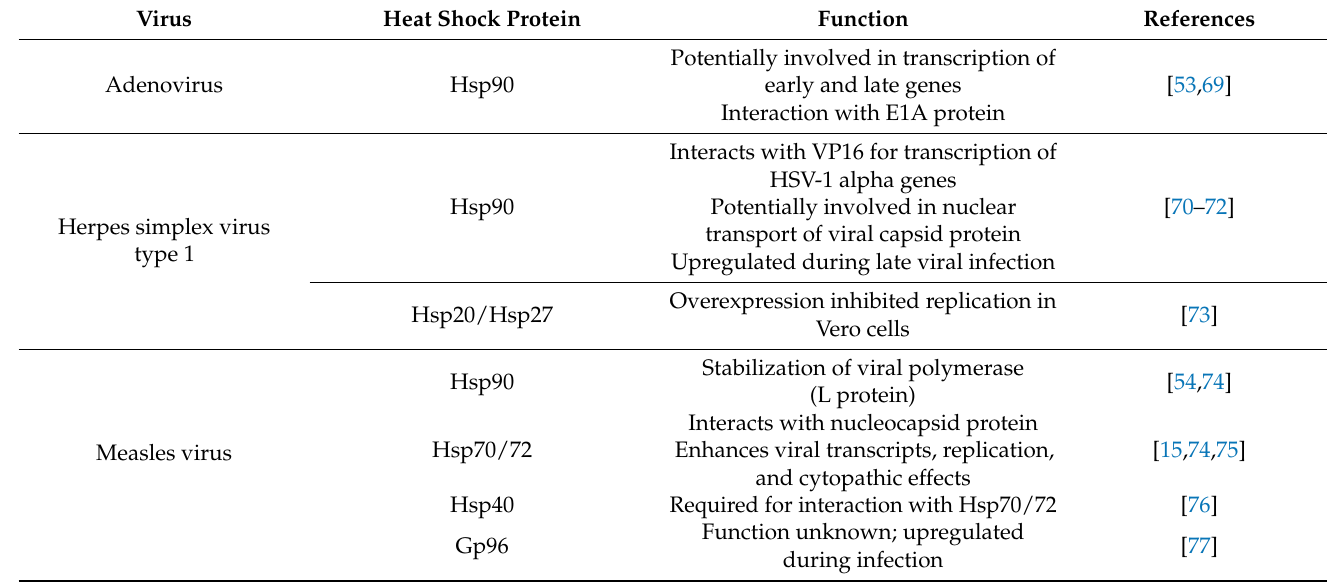
Table 1. Examples of heat shock protein (Hsp) involvement in oncolytic virus replication.